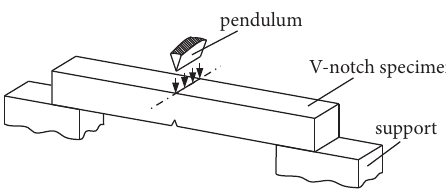
Figure 1: V-notch specimen struck by a pendulum